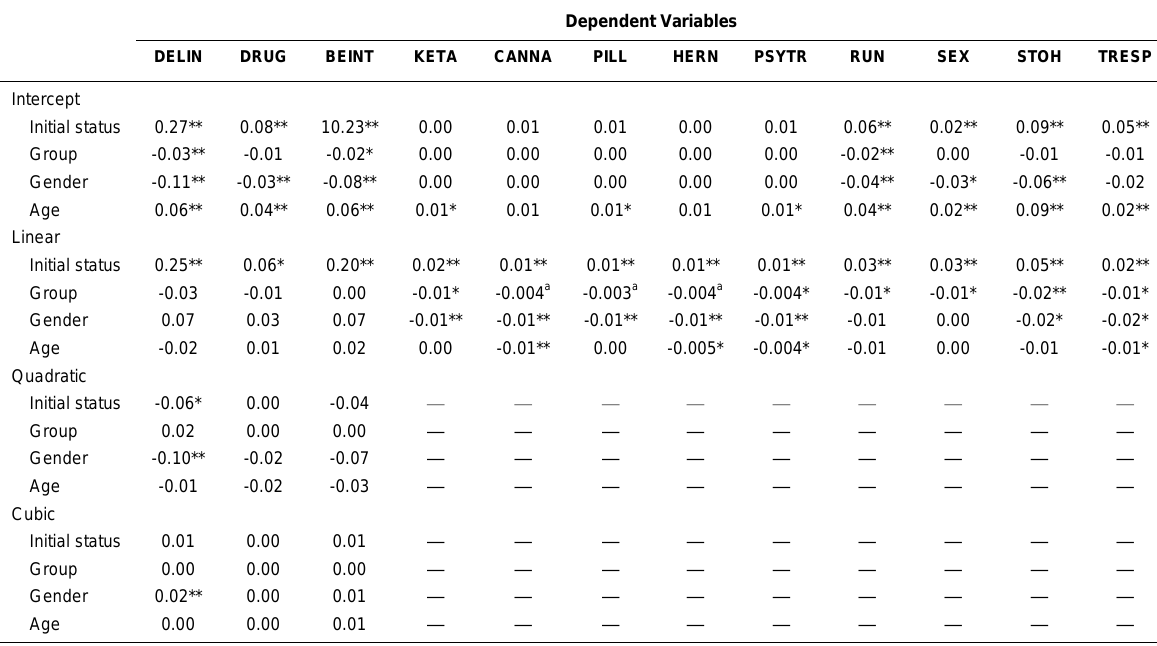
Growth Curve Models for Problem Behavior Indicators with Subjects who Joined the Tier 1 Program as Experimental